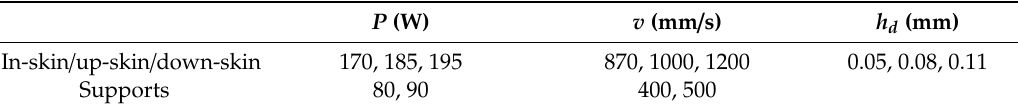
Table 1. Process